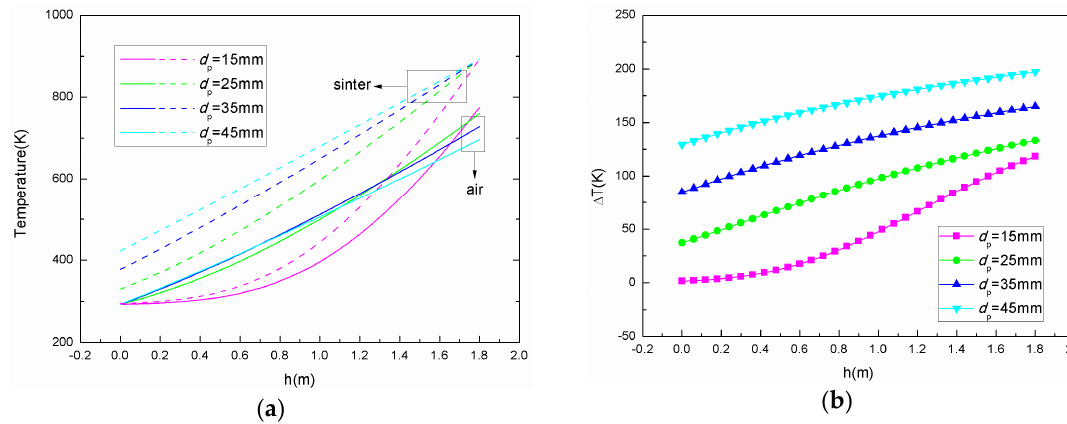
Figure 16. ( a ) The average cross-sectional temperature distribution of air and sinter; ( b ) the temperature differences between sinter and air along the height of the sinter bed layer for different sinter particle diameters.